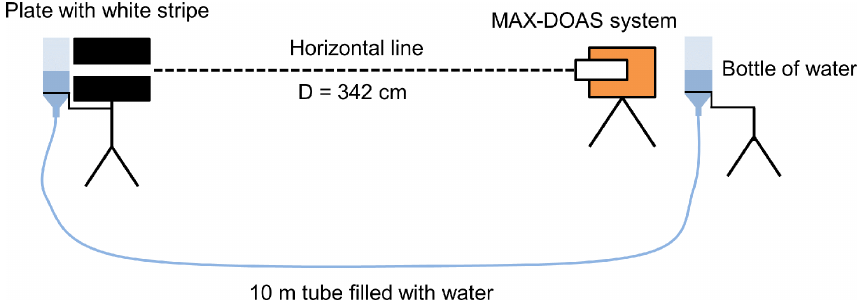
Figure 9. Sketch of the measurement setup used by MPIC for the white-stripe scans and the alignment of the telescope and white stripe using a water